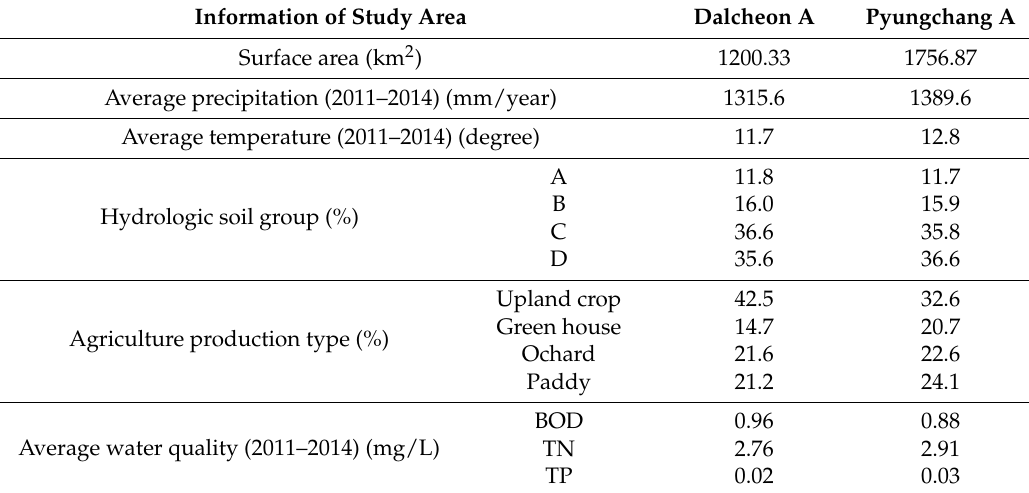
Table 4. Information of the study